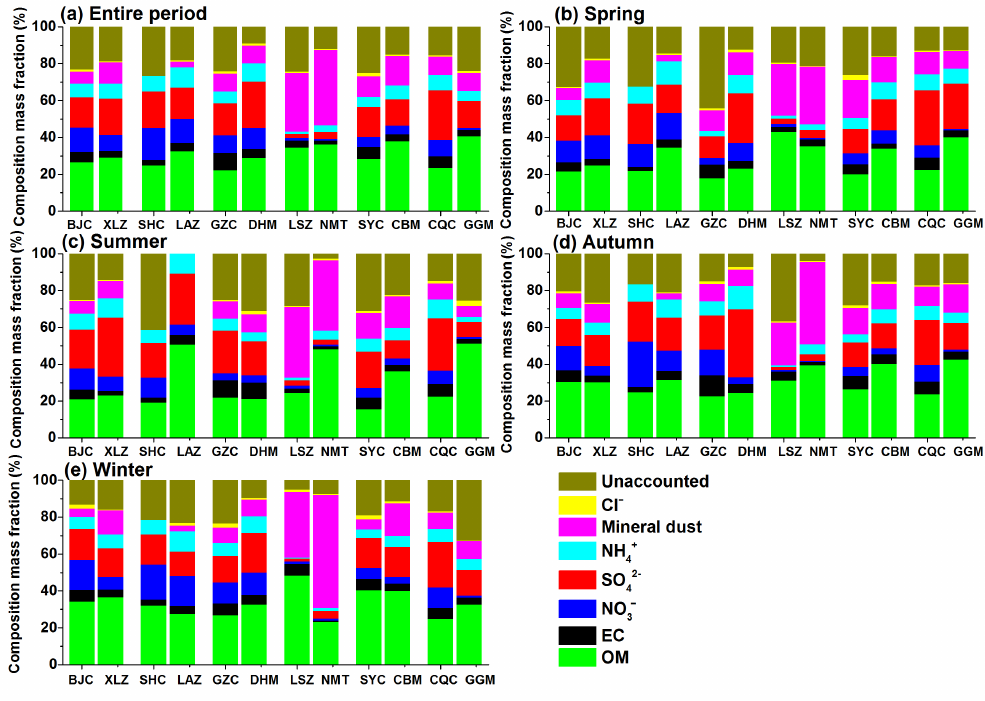
Figure 5. Average chemical composition of PM 2 . 5 at individual sites during (a) the entire period and (b–e) the individual seasons. The unaccounted matter refers to the difference between the PM 2 . 5 gravimetric mass and the sum of the PM constituents (OM, EC, SO 2 − NH + ,Mineral dust and Cl − ). The site codes related to the observation stations can be found in Table 4